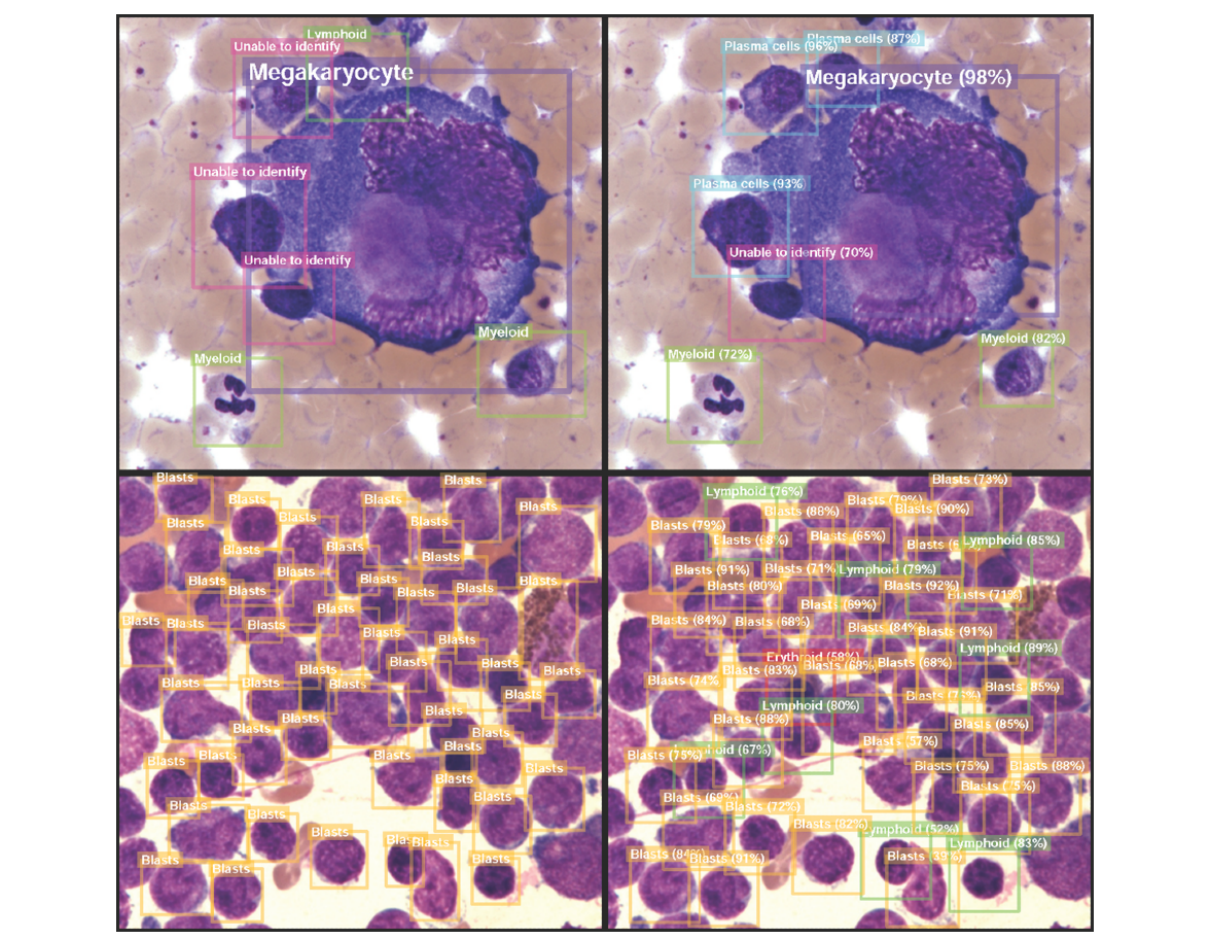
Figure 5. Selected inconsistent results between the hematologists and the artificial intelligence model. The images in the left column are the consensus from hematologists in the morphological assessment of each cell, and the images in the right column are the predictions of BMSNet. From top to bottom are a normal case and an acute leukemia case. The colors of the bounding boxes represent the categories of the contained